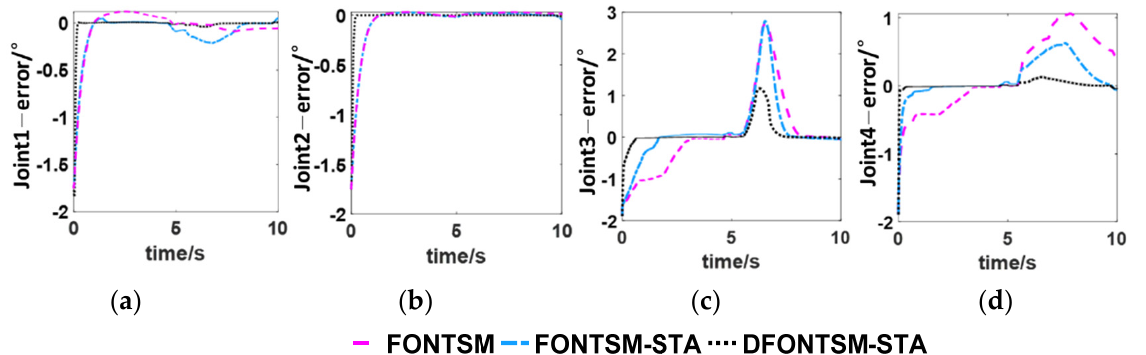
Figure 3. The position tracking error of each joint. ( a ): joint one; ( b ): joint two; ( c ): joint three; ( d ): joint four.